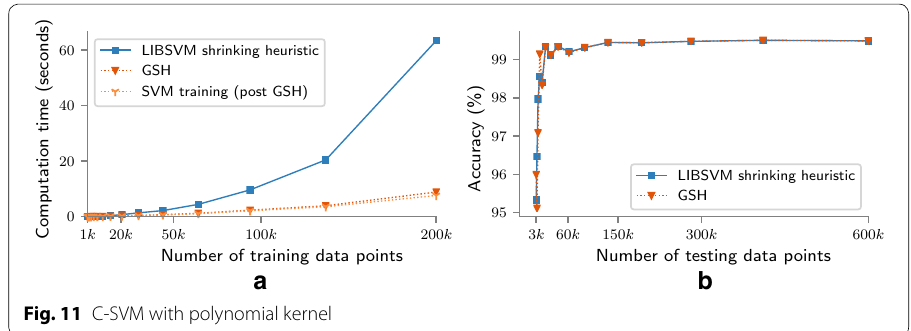
Fig. 11 C-SVM with polynomial kernel